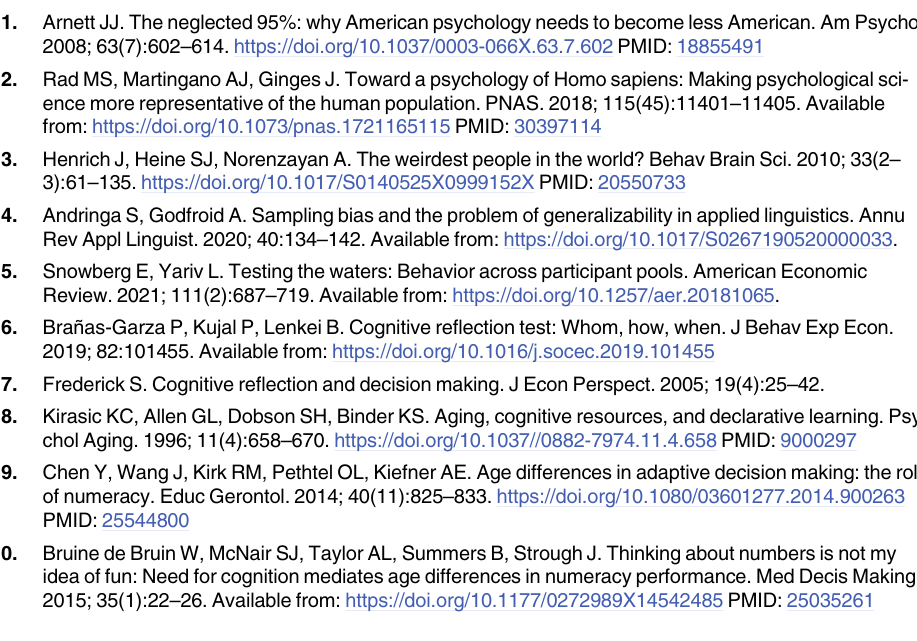
S63 Fig. Distribution of numeracy skills among the Student, Young and General samples of Sweden. The red curve represents the Student sample, green represents the Young Sample, and blue represents the General sample. S64 Fig. Distribution of numeracy skills among the Student, Young and General samples of United States of America. The red curve represents the Student sample, green represents the Young Sample, and blue represents the General